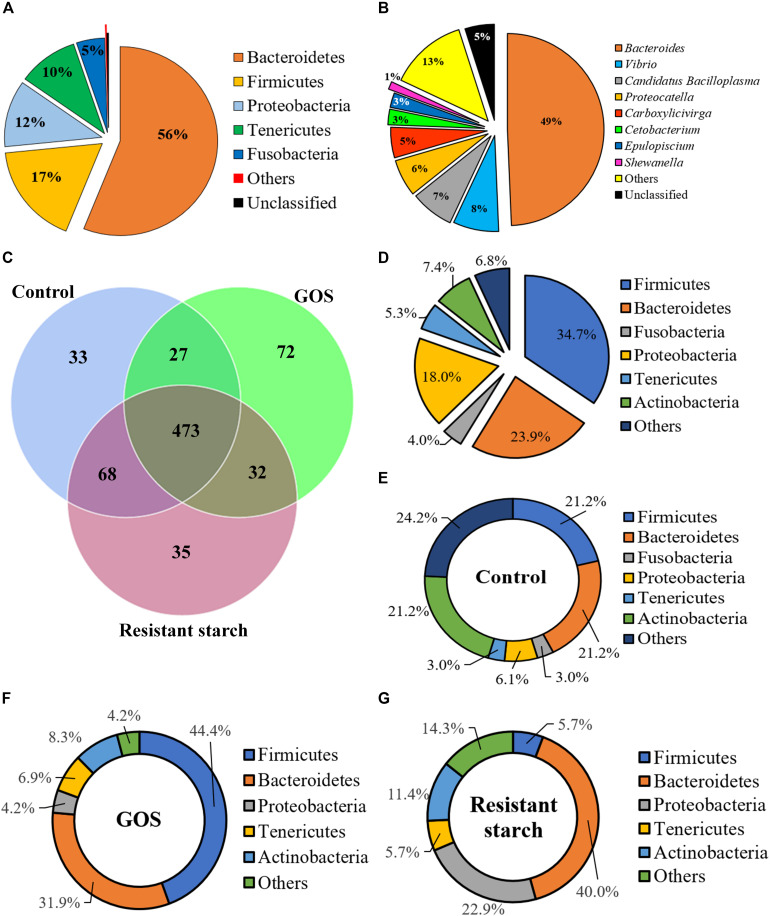
The composition of gut microbiota of galactooligosaccharides and resistant starch (using the combined data set) and the unique and shared OTUs in the cultures after a 24-h in vitro fermentation. (A) The five high-abundance phyla combined accounted for 99.53% of all OTUs, whereas low-abundance phyla accounted merely for 0.19% (marked as “others”) and 0.28% (“unclassified”). (B) The five genera with abundance ≥ 1% accounted for 81.92% of the total microbiota; the sequences that could not be classified into any known genus were marked as “unclassified” (accounting for 5.0%). (C) Venn diagram shows the number of shared and unique OTUs among the samples in different groups (the phylum level). (D–G) Pie charts show the characteristics of shared OTUs (D) and unique OTUs in the samples in controls (E), GOS (F), and resistant starch (G) groups (at the phylum level).